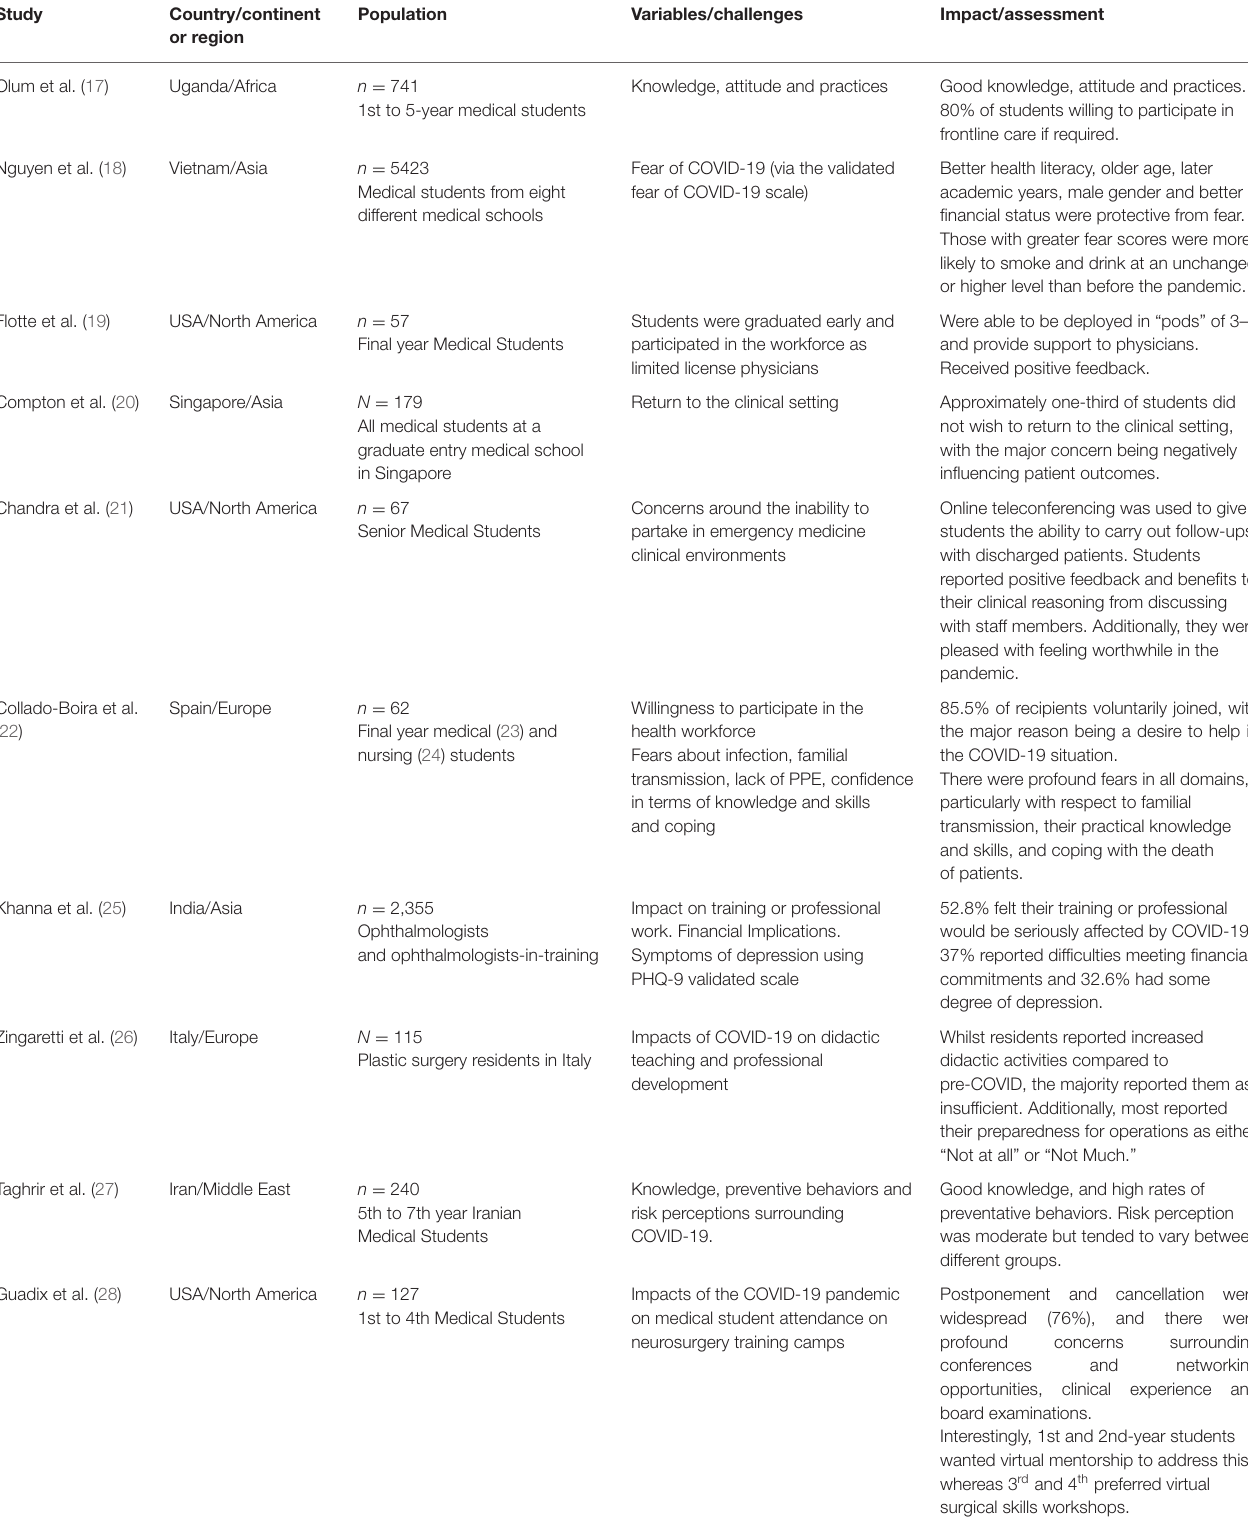
TABLE 2 | Impact of COVID-19 on medical education, training and mental health of medical students and